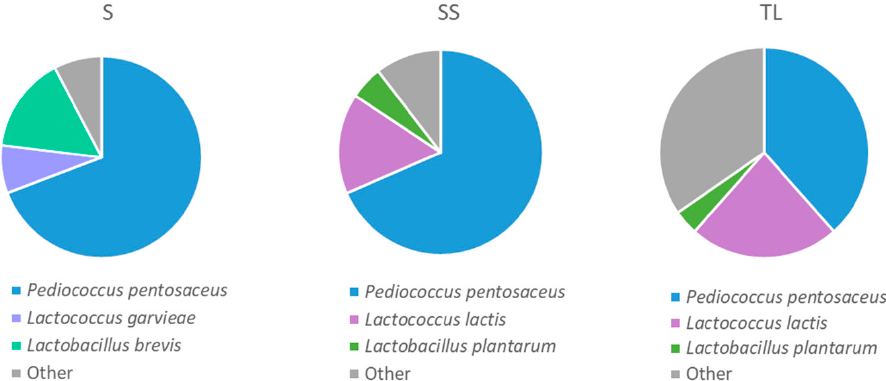
Figure 5. Proportion of LAB species isolated in MRS at 24 h after vatting in the different inoculation strategies (SS: spontaneous sulfite, S: spontaneous without SO 2 , TL: inoculation with T. delbrueckii / L. thermotolerans at vatting without SO 2 ).